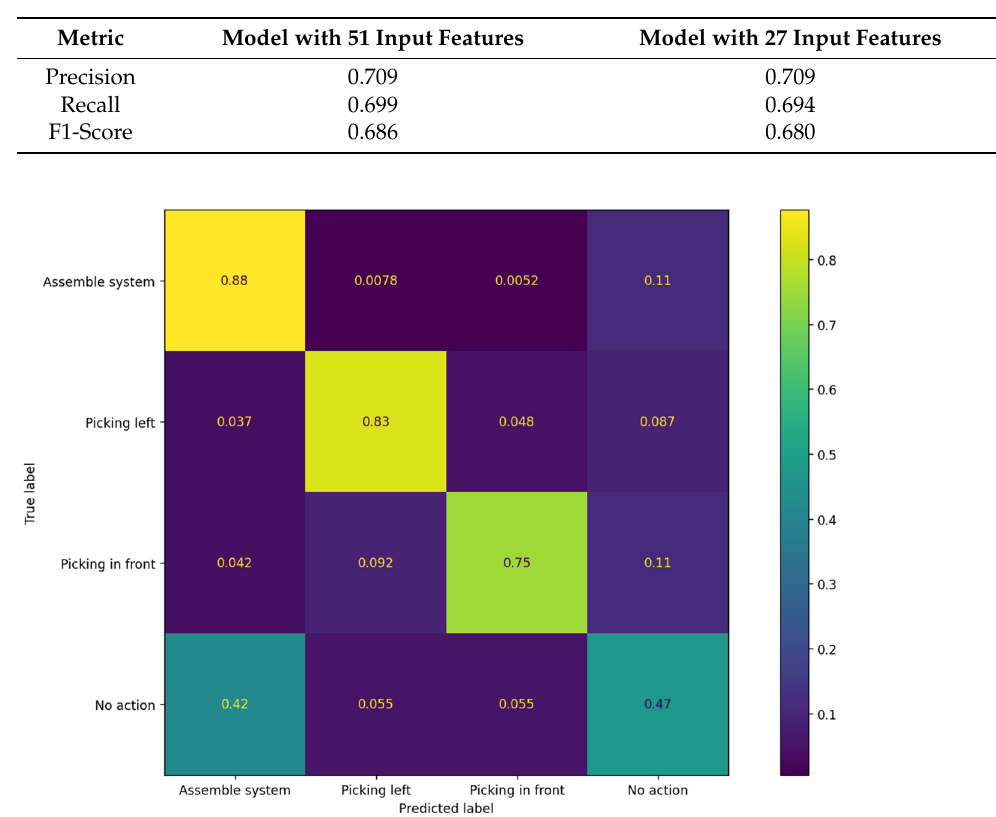
Figure 11. Confusion matrix for the model with 27 input features (nine joints).